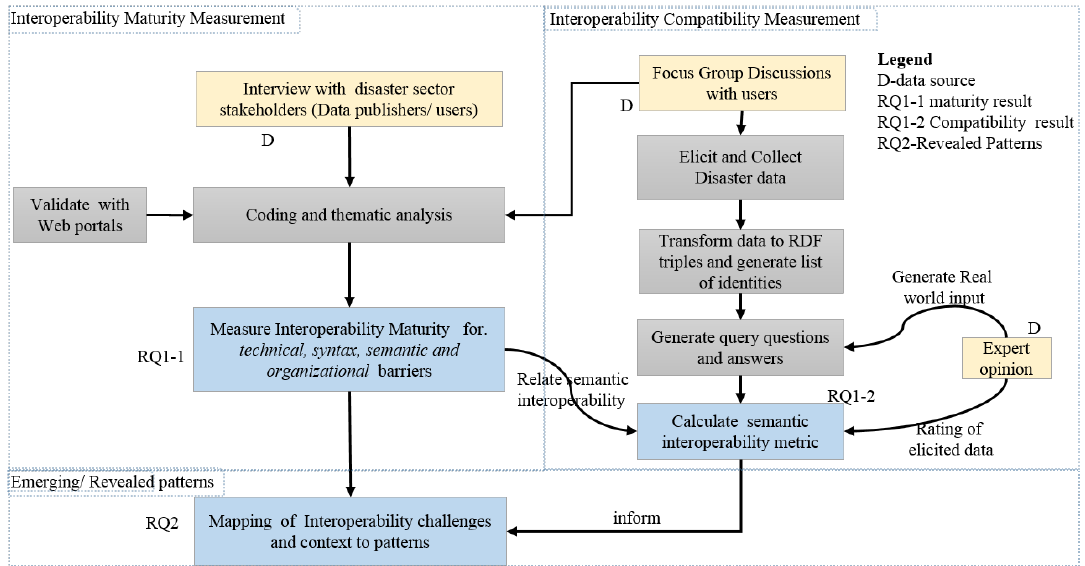
Figure 1. General flow of